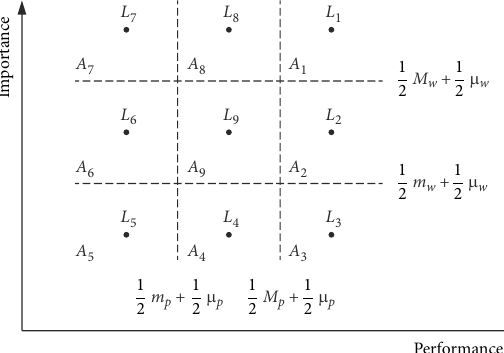
Figure 4. Nine categories approach, the associated prototypes and thresholding